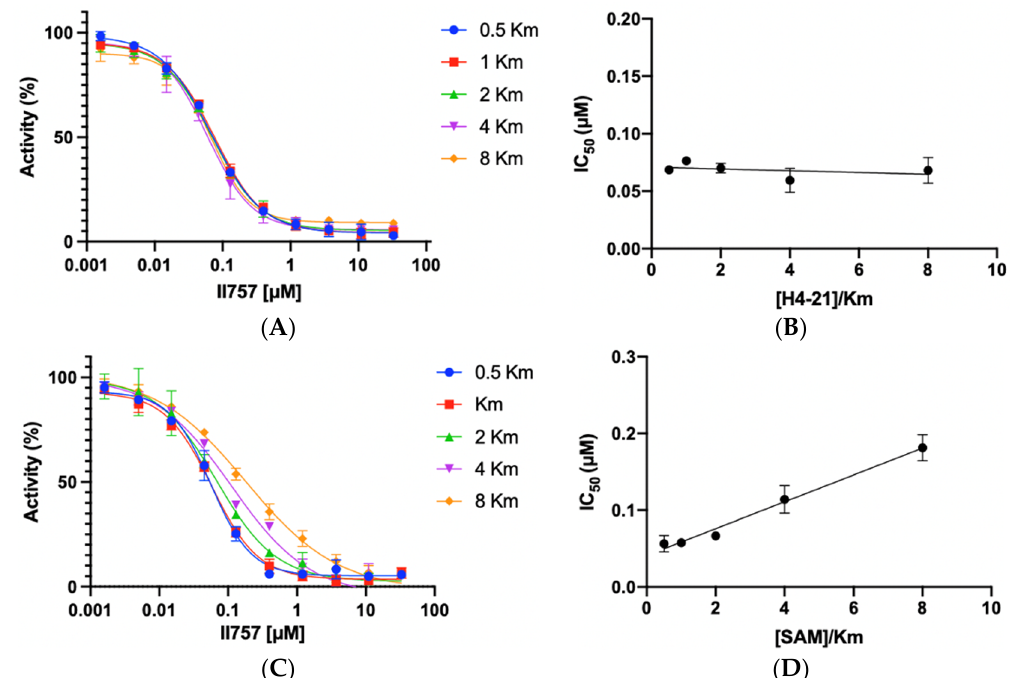
Figure 4. Inhibition mechanism studies of II757 : ( A ) IC 50 curves of 6l at varying concentrations of substrate (H4-21) with a fixed concentration of SAM at 10 µ M, ( B ) linear regression plot of IC 50 values with corresponding concentrations of substrate (H4-21), ( C ) IC 50 curves of 6l at varying concentrations of SAM with a fixed concentration of substrate (H4-21) at 5 µ M, and ( D ) linear regression plot of IC 50 values with corresponding concentrations of SAM. All experiments were performed in duplicates (n = 2).